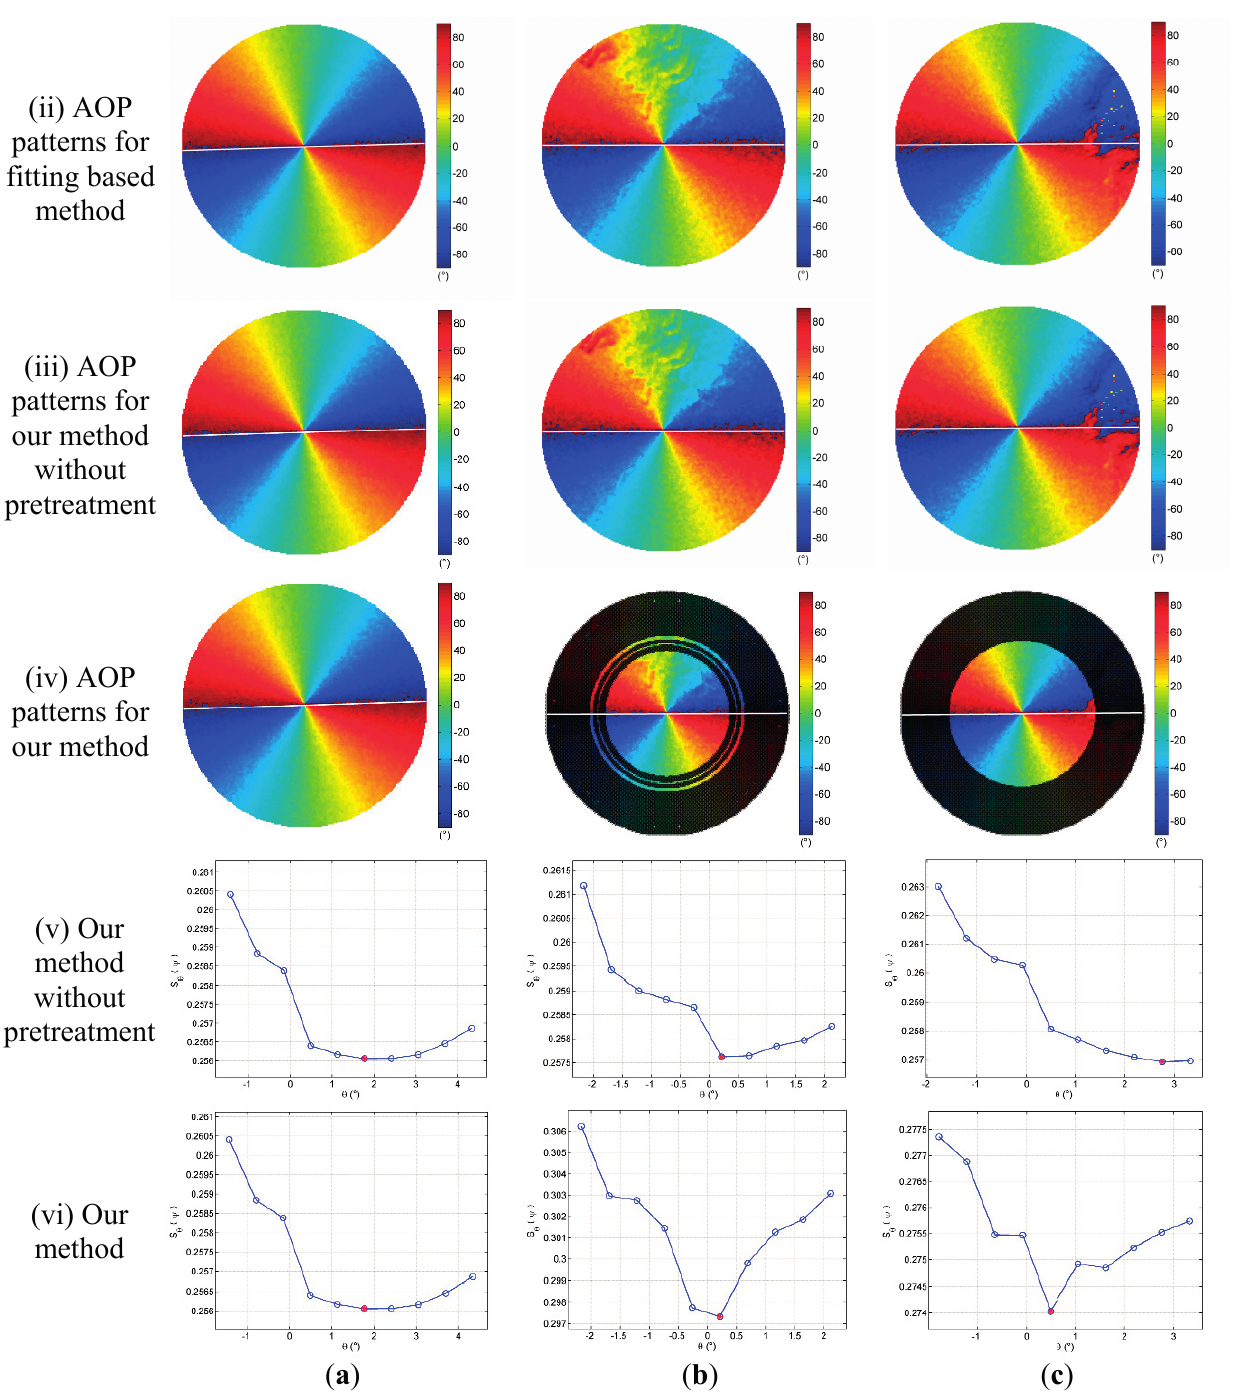
Figure 10. The AOP and DOP patterns in a circle of radius 100 pixels centered at the origin. ( a ) Clear sky, ( b ) Cloudy sky I, and ( c ) Cloudy sky II. (The white lines in row (ii) are the solar meridian orientations extracted by fitting based method; the white lines in row (iii) are the solar meridian orientations extracted by our method without pretreatment; the white lines in row (iv) are the solar meridian orientations extracted by our method; the black crosses in row (iv) indicate the points set to